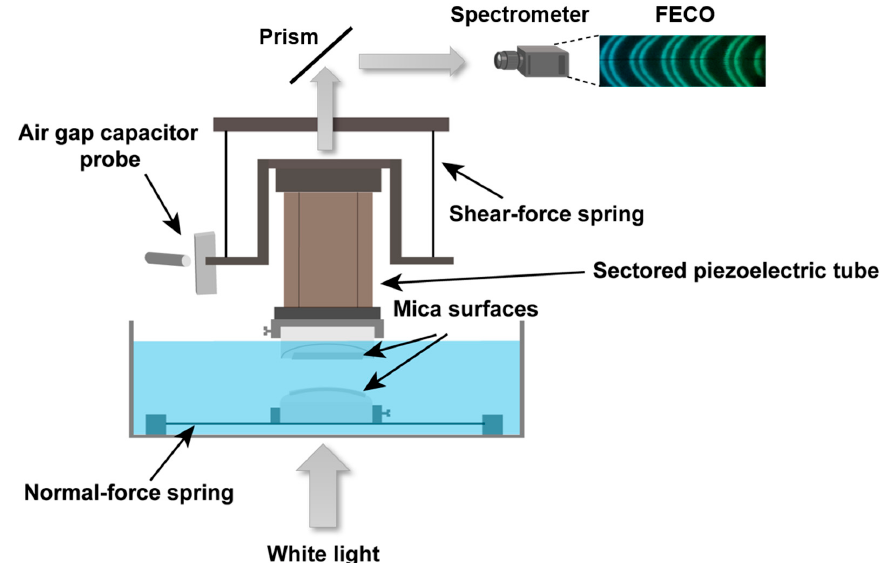
Figure 4. Schematic illustration of the surface force balance (SFB) setup, where normal and shear forces between two surfaces are directly measured via the bending of two orthogonal springs. White light undergoes multiple beam interference in passing through the half-silvered mica sheets, resulting in Fringes of Equal Chromatic Order (FECO, top right inset). These yield absolute separation between the surfaces to within ±0.2 nm. A sectored piezoelectric tube can move the surfaces normally and laterally relative to each other. The bending of normal and shear springs in response to applied motion, monitored via the change in an air gap capacitor or through changes in the interface fringes, directly reveals the shear and normal forces, respectively.